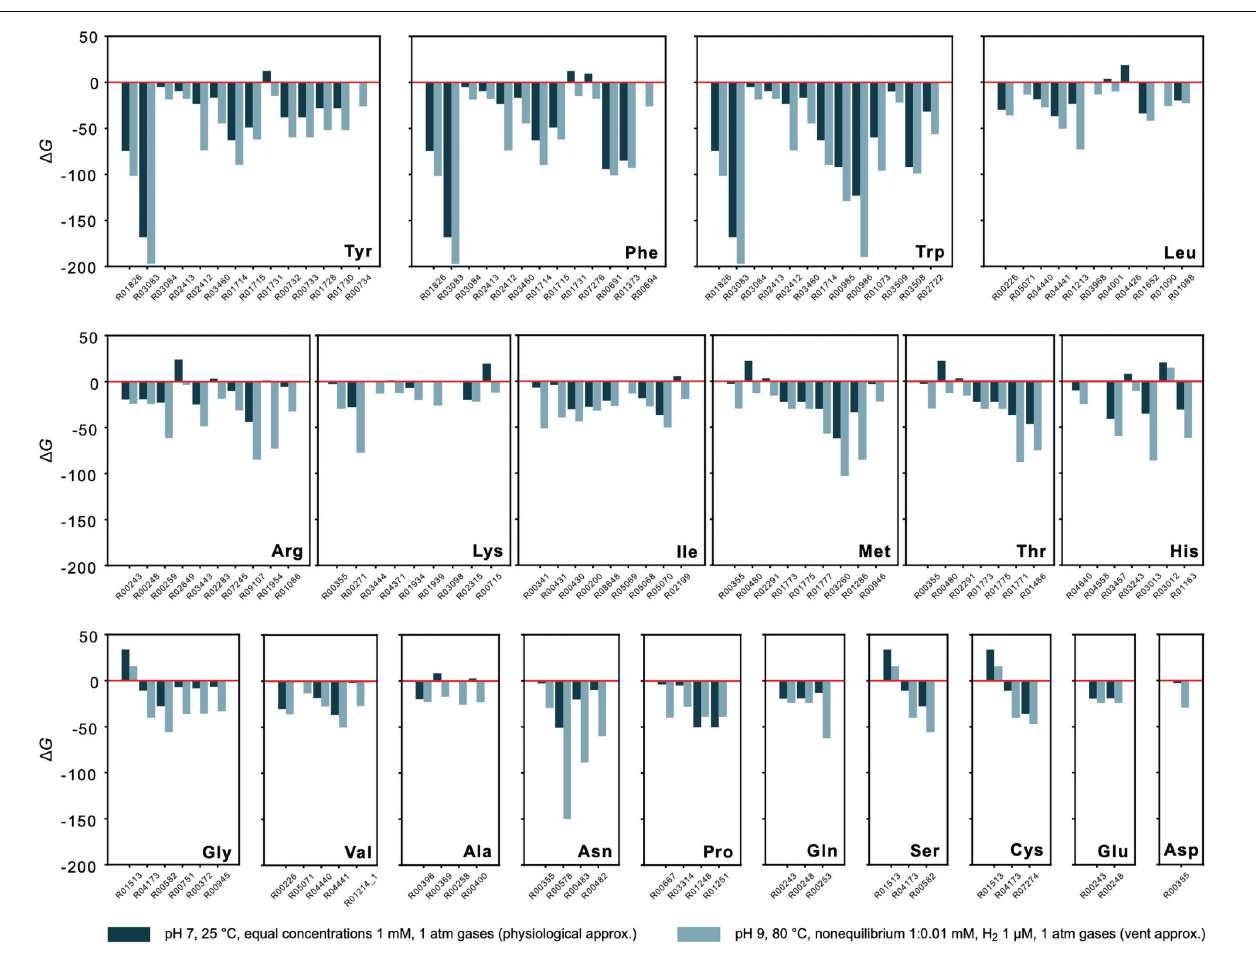
FIGURE 4 | Energetics of amino acid synthesis. Gibbs energies (cid:49) G were calculated for reactions involved in the synthesis of the 20 canonical amino acids. Only reactions yielding a value for (cid:49) G are plotted. Values of (cid:49) G are indicated for physiological (dark blue) and vent conditions (light blue) as defined in the figure. Underlying synthesis pathways are listed in Supplementary Table 7 . Only pathways starting from key intermediates pyruvate, oxalacetate, 2-oxoglutarate, phosphoenolpyruvate, 3-phosphoglycerate, and C5 sugars (as proposed in Martin, 2020) are examined. Additional synthesis alternatives from KEGG are not taken into